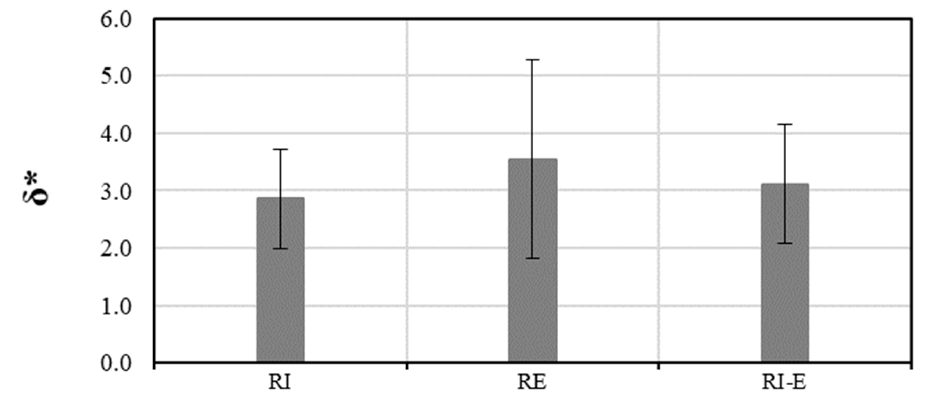
Figure 21. Dimensionless ductility of (UN), (RI), (RE) and (RI-E) buttressed arches.